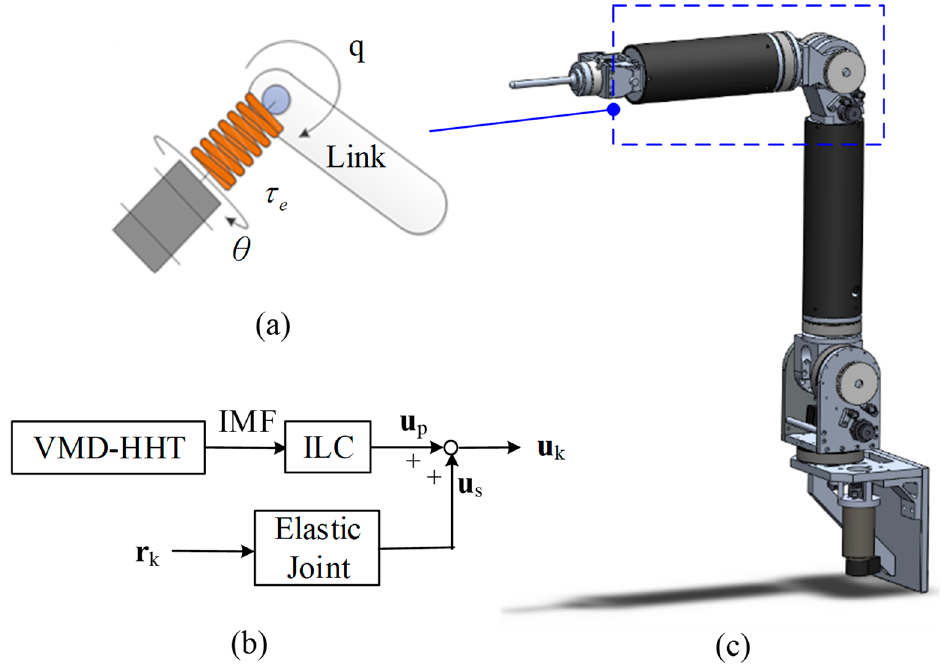
Figure 1. Illustration of the elastic joint for a robotic arm. ( a ) Elastic joint. ( b ) Flowchart of the VH-ILC-EJ method. ( c ) Robotic arm.